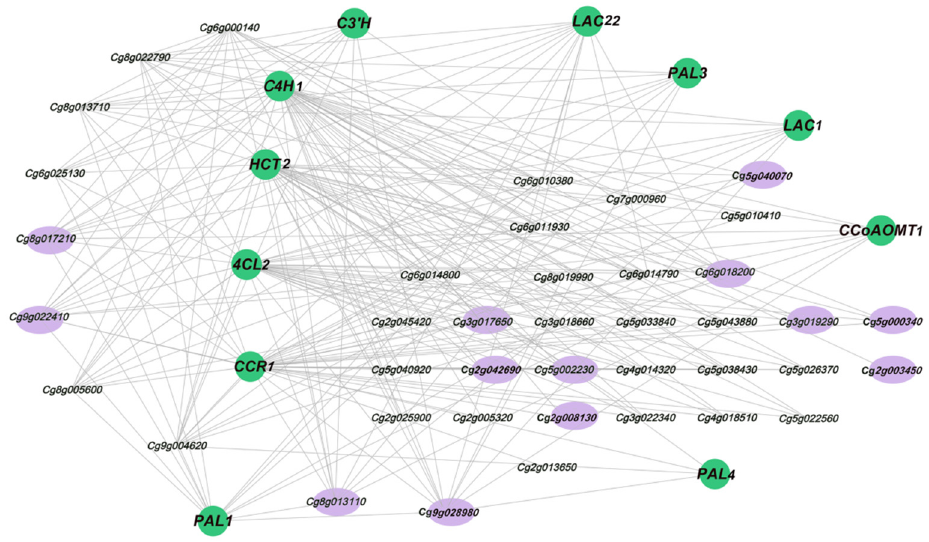
Figure 8. Construction of regulatory networks of lignin metabolism genes and transcription factors (TFs). Green nodes indicate structural genes related to lignin biosynthesis, and purple nodes indicate candidate TFs that may regulate the lignin